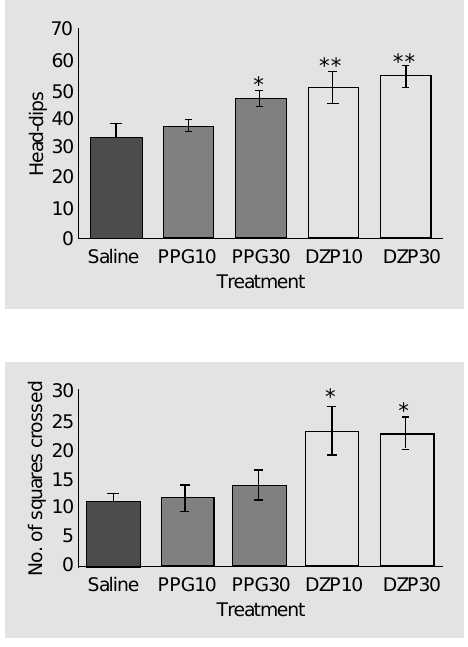
0 Saline PPG10 PPG30 DZP10